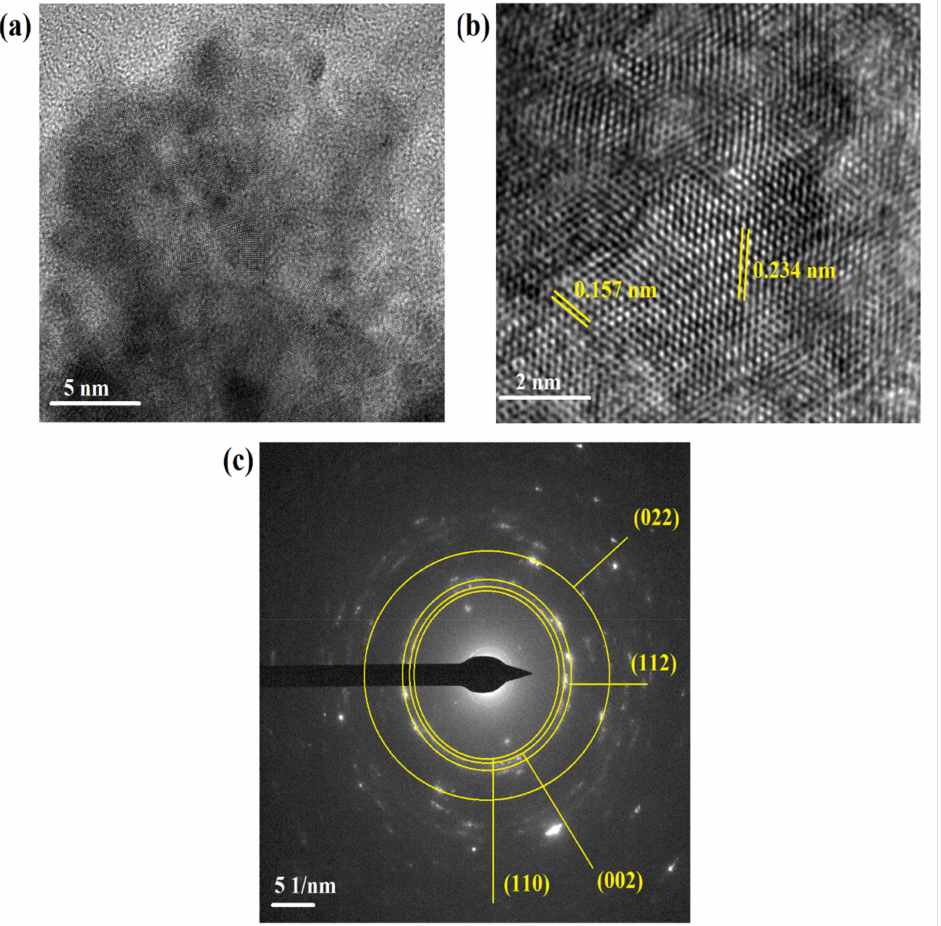
Figure 3. ( a ) HR-TEM image of MoCu-4, ( b ) HRTEM image of MoCu-4 and ( c ) SAED pattern of MoCu-4